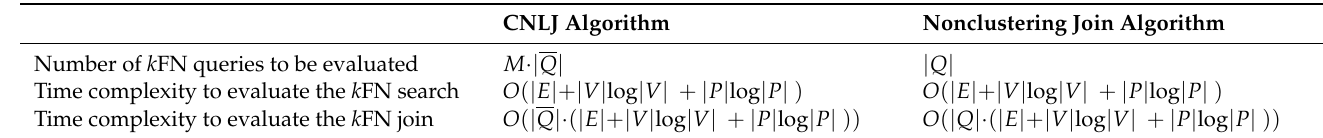
Table 4. Comparison of time complexities of the CNLJ and nonclustering join algorithms.